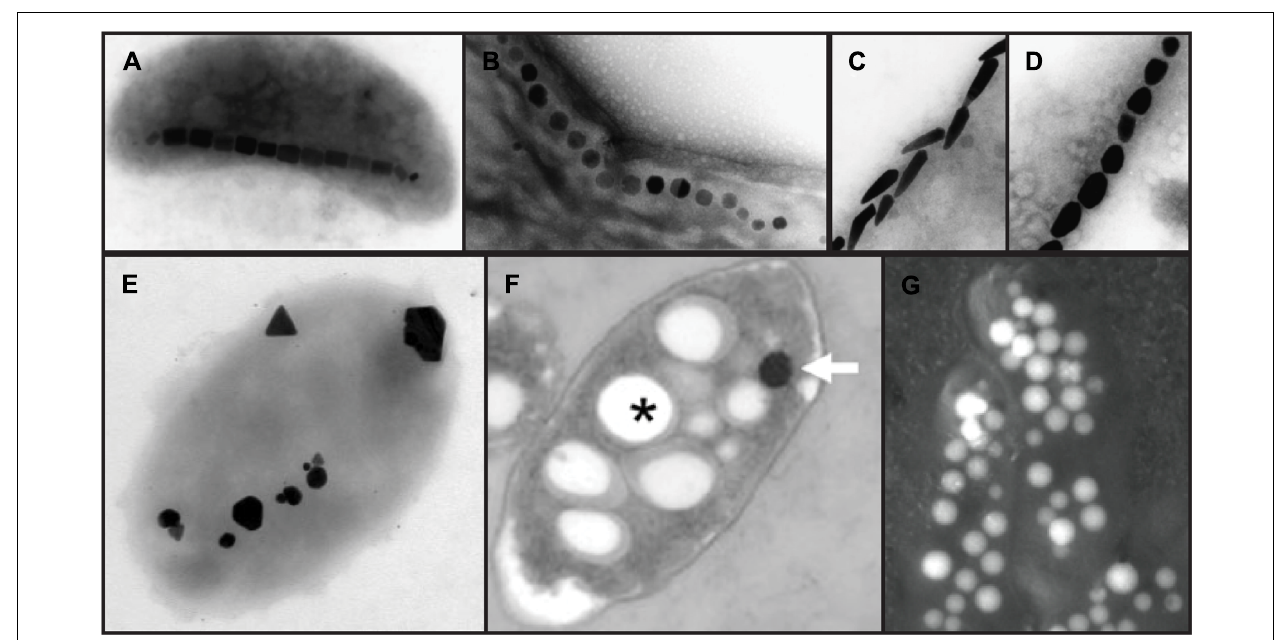
(Debieux etal., 2011). Asterisk, Poly(3-hydroxybutyrate) granule; arrow, selenium nanosphere. (G) , carbonate deposits in a cyanobacterium, copyright 2012 American Association for the Advancement of Science (Couradeau etal., 2012). In this backscatter scanning electron micrograph, electron dense carbonate deposits appear white. Images are not to